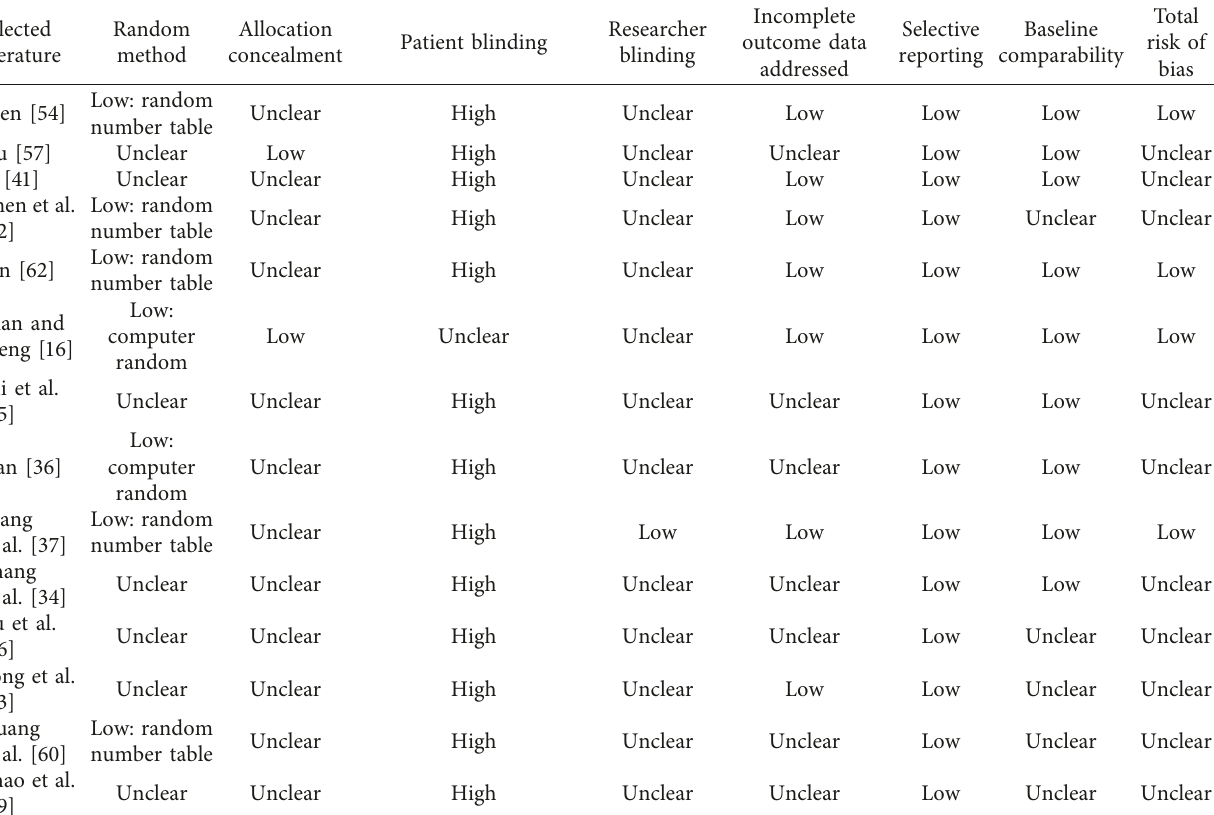
a Baseline symptom scoring